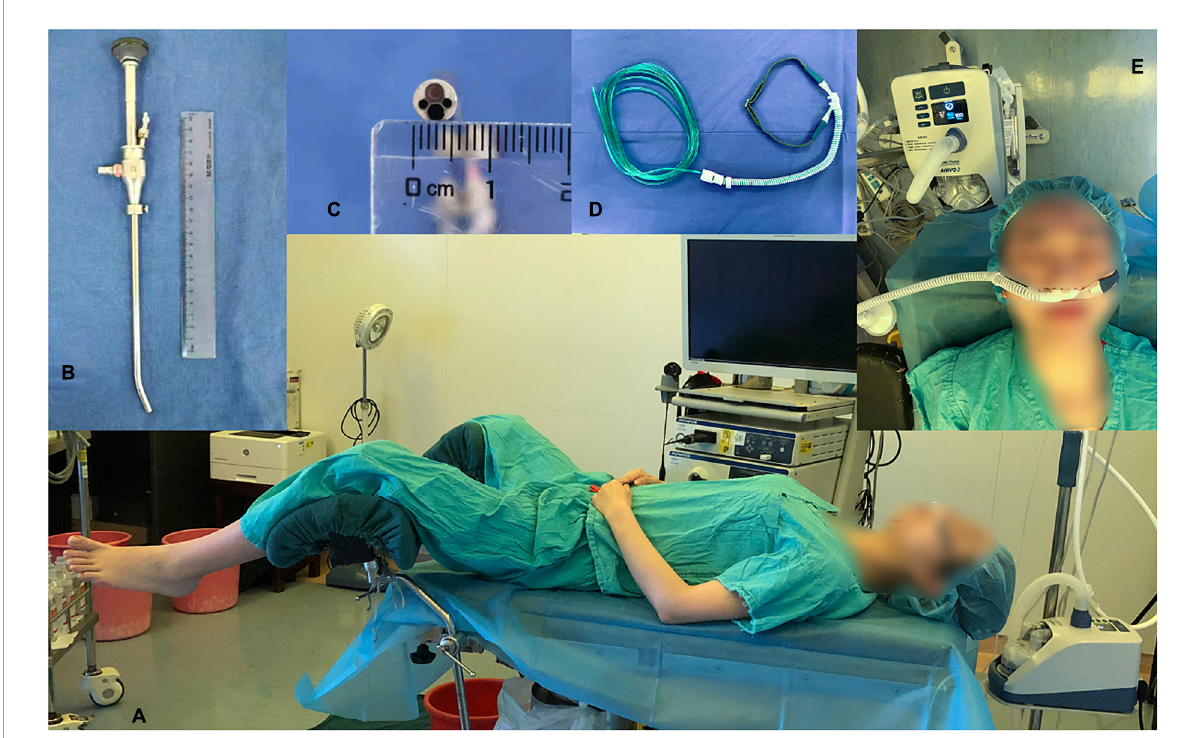
FIGURE1 Surgical position, a hysteroscope and a high-flow nasal oxygen device. (A) Lithotomy position. (B) Outlook of the hysteroscope with a rigid 6.5-mm outer diameter and a 22 ◦ fore-oblique. (C) The 6.5-mm diameters of the hysteroscope. (D) Nasal cannula covered by the HFNO cannula. (E) High-flow nasal oxygen device and the parameters set in the study: adjustable temperature (37 ◦ C), gas flow (30–60 L/min) and oxygen concentration